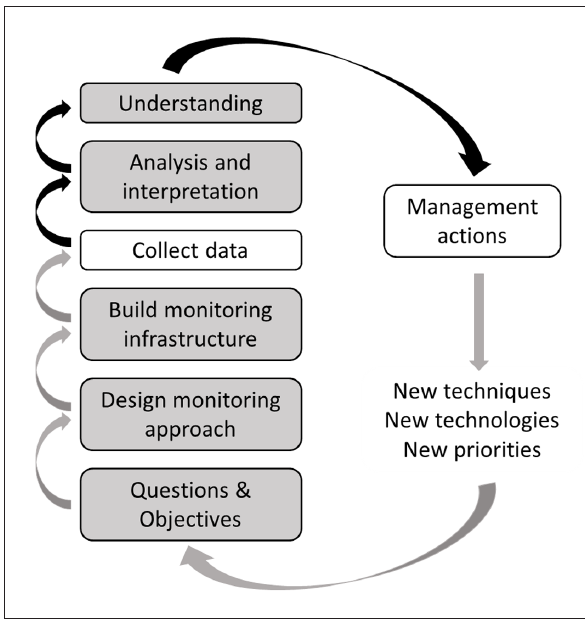
Figure 4: A schematic presentation of the community- based monitoring program in Prey Lang, Cambodia, showing where ICT facilitated the monitoring pro- cess (black arrows). Local community contributions are in white, and a combination of community and university scientist contributions are in grey. Adjusted from Brammer et al. 2016, based on the spectrum of stakeholder participation in environmental monitor- ing approaches (Danielsen et al. 2009; 2013b), mapped onto a modified adaptive-monitoring framework ( Lindenmayer and Likens